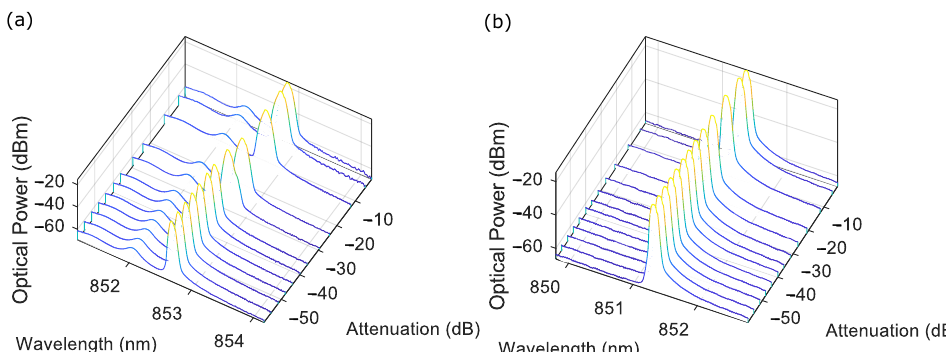
Figure 7. Laser spectra for different feedback levels (attenuation) for a static target. ( a ) VCSEL spectrum at a bias current of 7 mA and laser temperature of 35 ◦ C. ( b ) DFB spectrum at a bias current of 70 mA and laser temperature of 25 ◦